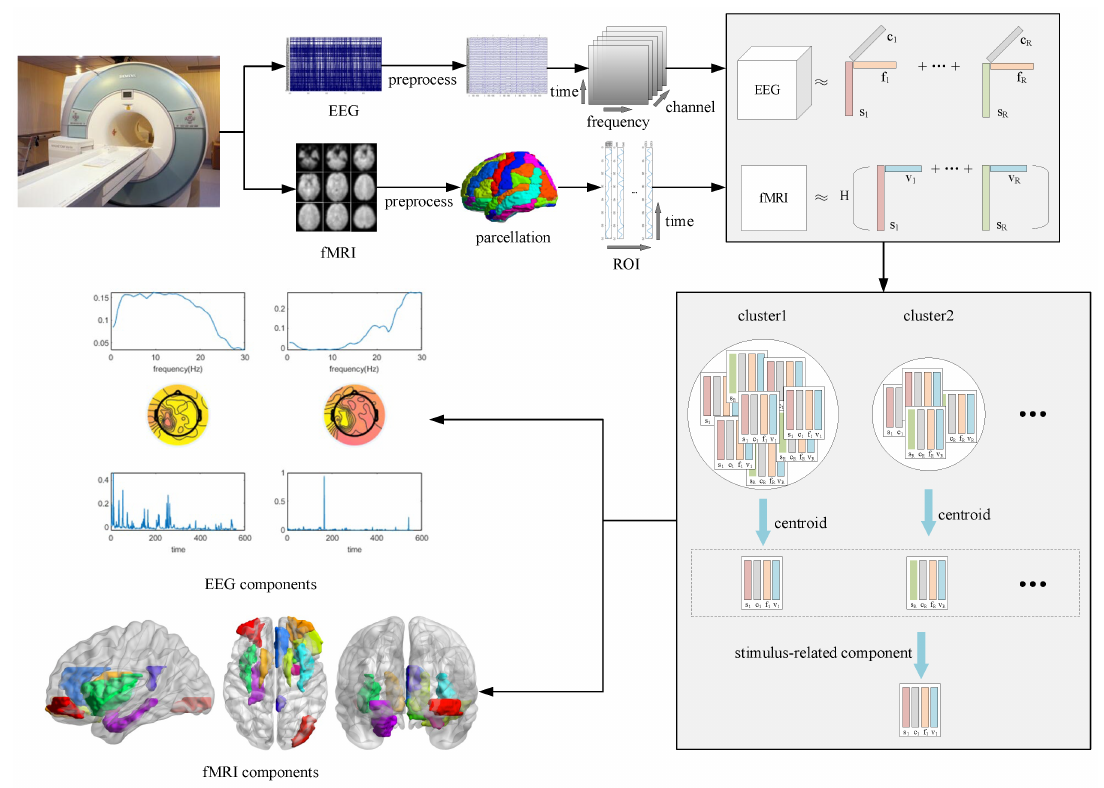
Figure 1. Using the CMTF method, the simultaneous EEG-fMRI data were jointly decomposed to capture ROIs activated by reward processing. The collected data went through preprocessing, dimensional expansion of EEG data, CMTF, and model selection. After using graph-structured clustering, the best model was selected by four quantitative metrics, CORCONDIA, reproducibility, similarity, and significance, to obtain the fMRI components (ROI factors) and the corresponding EEG components (frequency factors, channel factors, and time